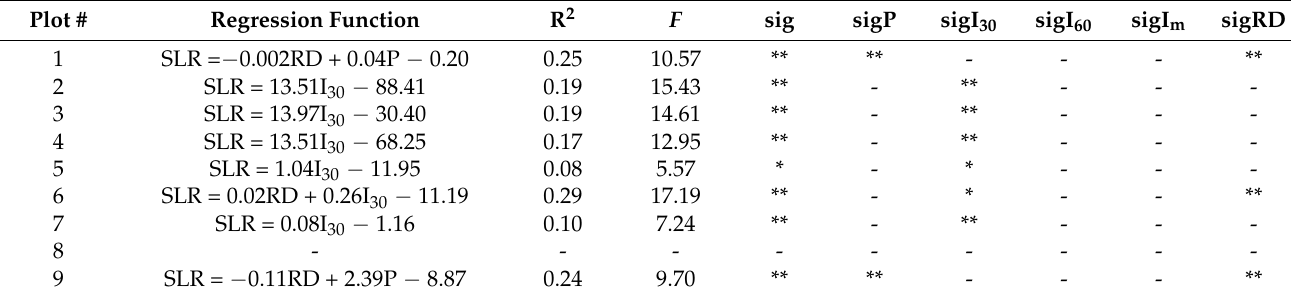
Table 6. Multiple regression analysis for soil loss rate (SLR) and the five rainfall eigenvalues of rainfall amount (P), rainfall duration (RD), mean rainfall intensity (I m ), maximum 30 min rainfall intensity (I 30 ), and maximum 60 min rainfall intensity (I 60 ). Regression